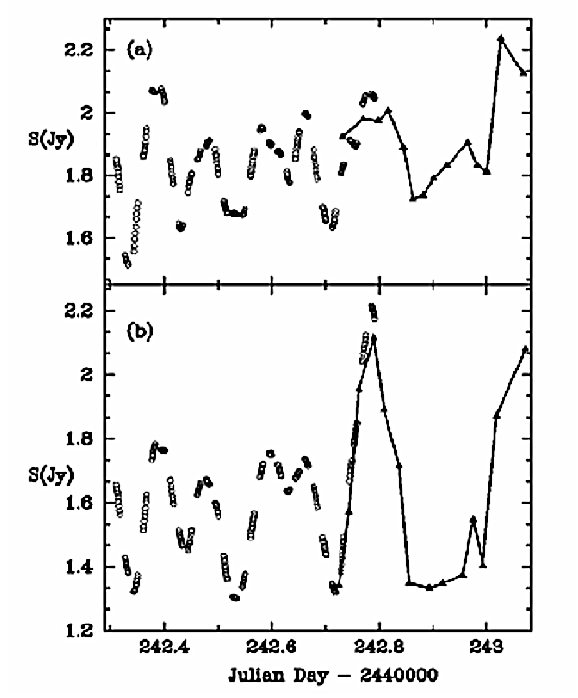
Figure 4. The combined ATCA and HARTRAO light curves for PKS0405-385 on 8 June 1996 at ( a ) 8.6/8.4 GHz and ( b ) 4.8/5.0 GHz, from [17] DOI:10.1086/311001. c (cid:13) AAS. Reproduced with permission from